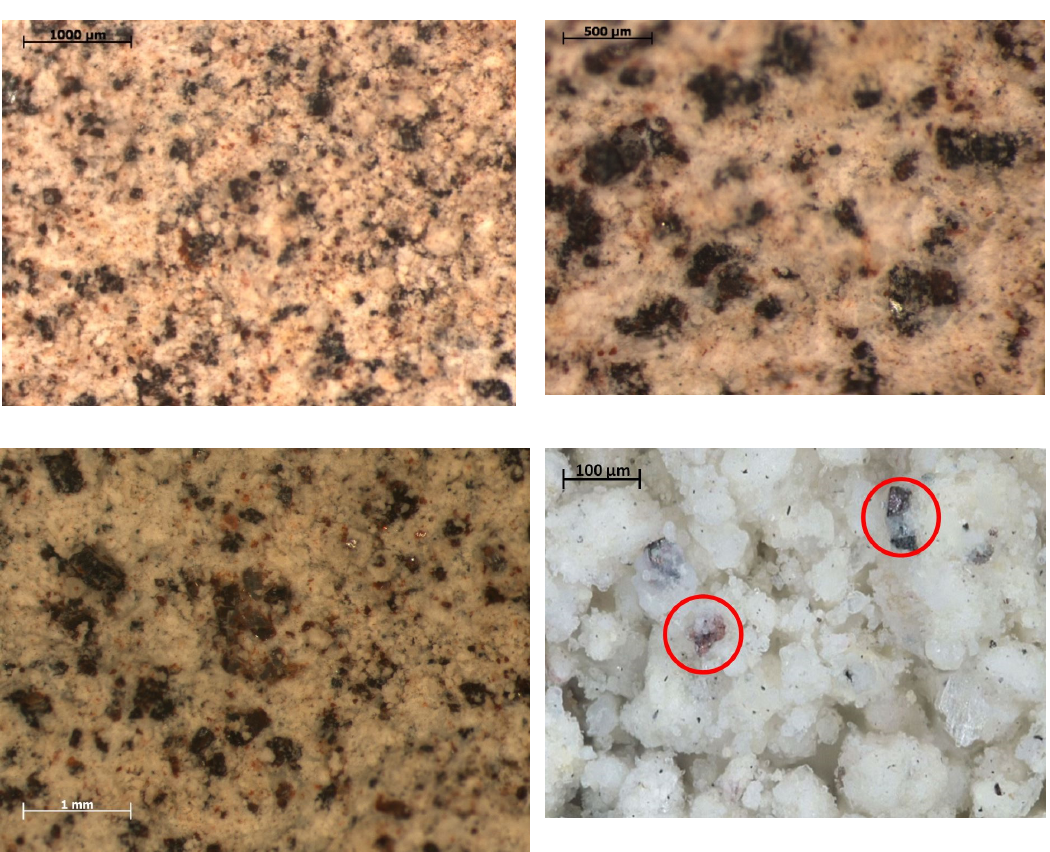
Figure 2. The structure of mineral from the Dunino deposit (LM). Selected samples from different areas of deposit with visible hematite and magnetite grains of various sizes (red circles).